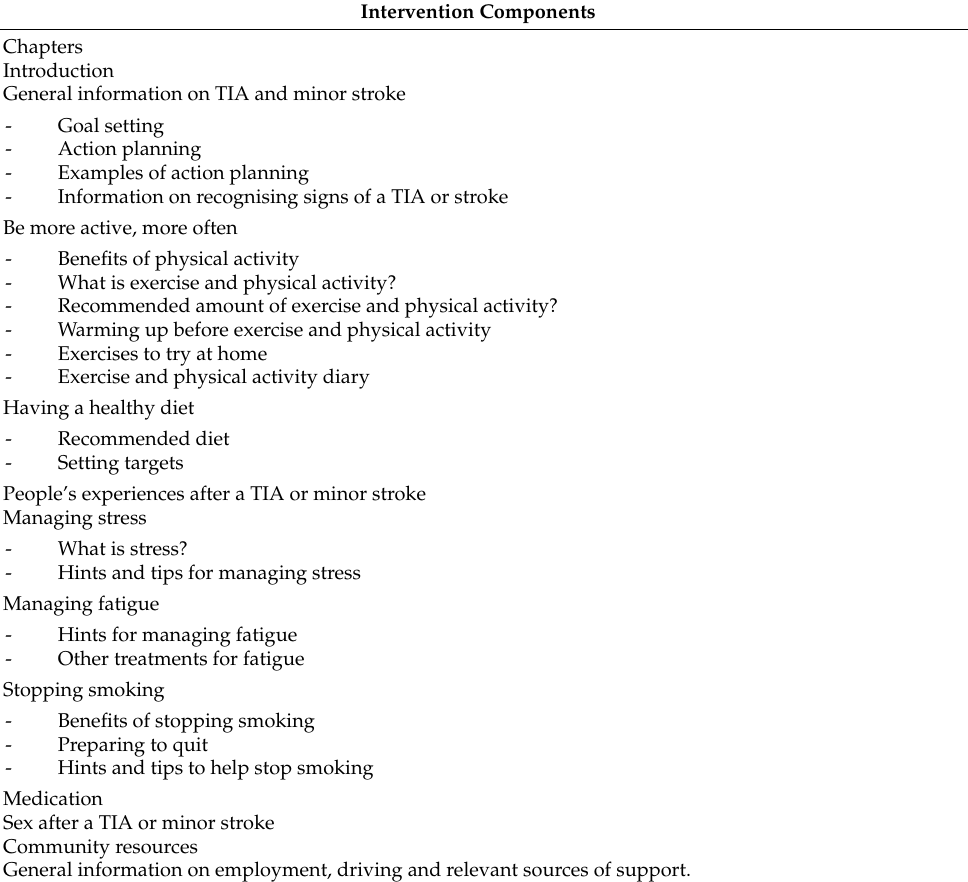
Table 2. Core components of the ‘Brain-Fit’